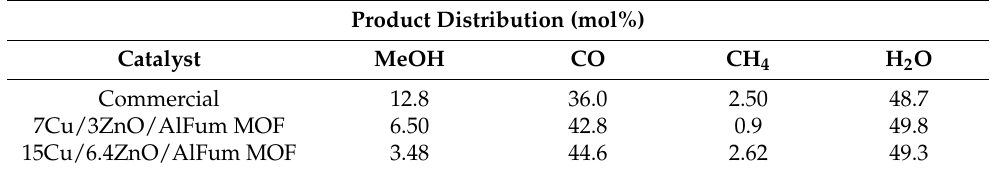
Table 2. Product distribution for all the evaluated